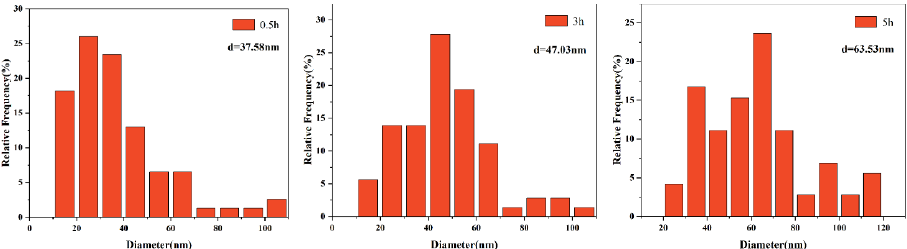
Figure 8. The distribution of NbC precipitates size after different holding time at the austenitizing temperature of 1050 °C.